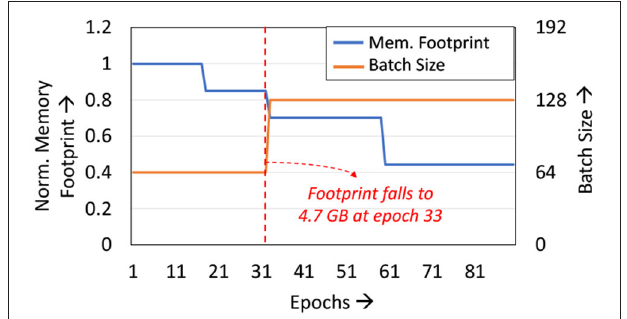
TABLE 2 | Cifar10 and Cifar100.